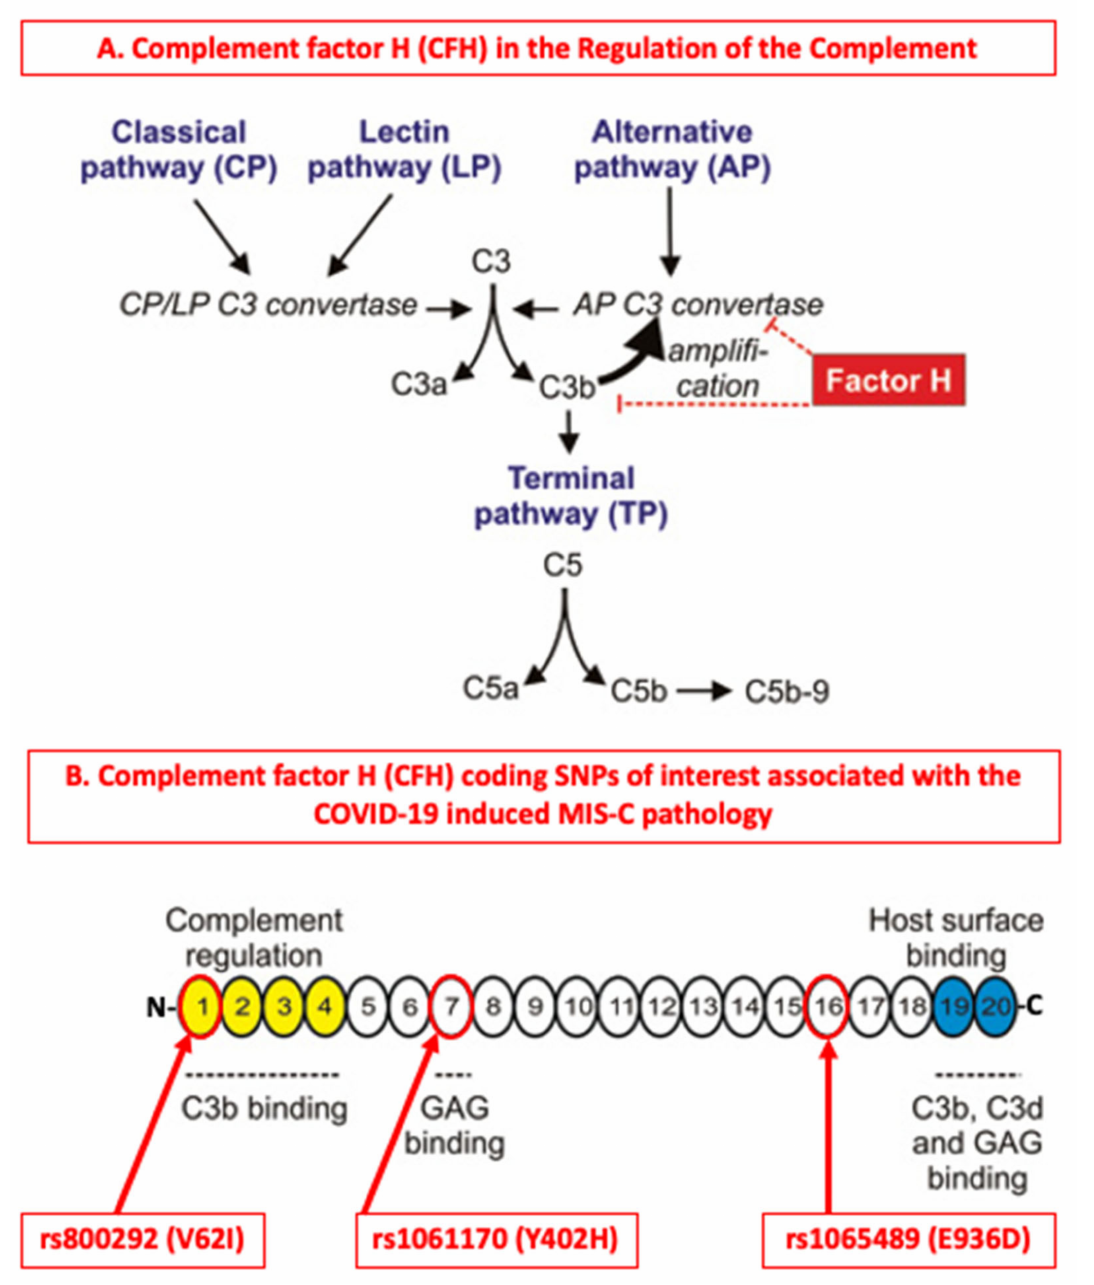
Figure 1. The contributions of complement factor H (CFH) and its associated coding SNPs in the regulation of the complement system. ( A ) Complement factor H (CFH) is one of the major regulators of the complement system by exhibiting decay accelerating activity against the C3bBb alternative pathway (AP) convertase and by acting as the major soluble cofactor for the complement factor I (CFI) mediated fragmentation of C3(H 2 O)/C3b [37]. The cleavage products iC3b, C3dg, and C3d are major opsonins of the complement system [38]. ( B ) Domain topography of the human CFH and the highlighting of coding SNPs of interest associated with the MIS-C pathology. Each numbered circle corresponds to one of the 20 complement control protein (CCP) (or short consensus repeat (SCR) or Sushi) domains of CFH. N- for the -NH 2 terminal end, -C for the -COOH terminal end. GAGs: Glucosamino glycans, MIS-C: Multisystem Inflammatory Syndrome in Children. This image originates from the Fülöp, TG et al. 2015 with modifications